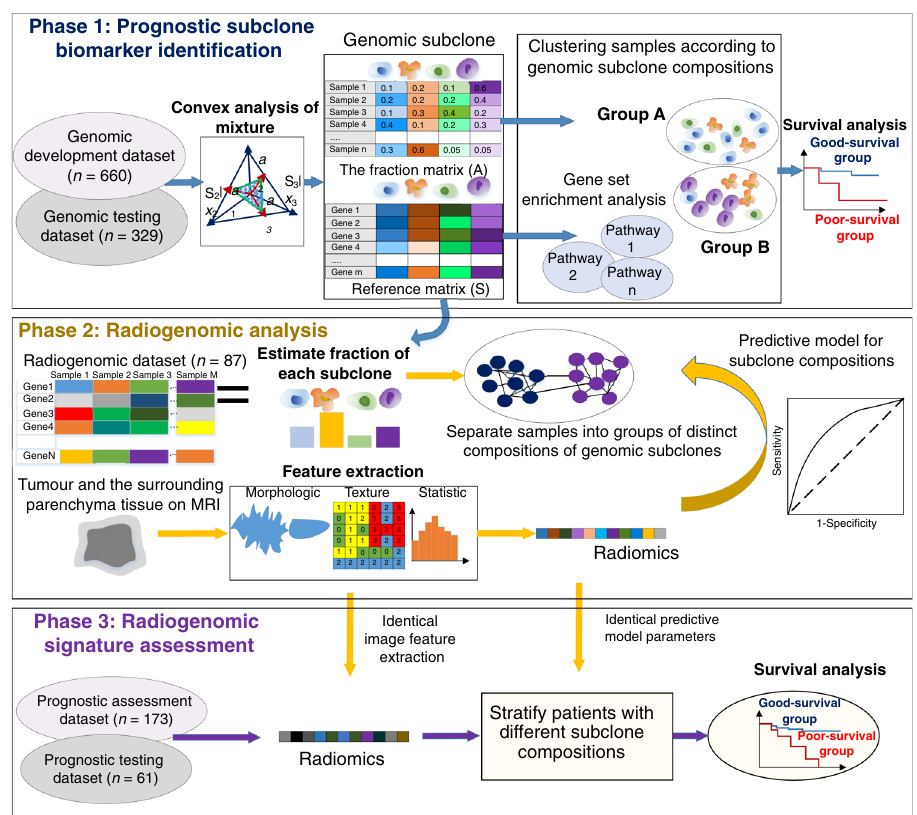
Fig. 1 Framework of the study with three phases. First (phase 1), prognostic subclone biomarkers are identi fi ed using a fully unsupervised deconvolution analysis of gene expression pro fi les. Biological functions of the subclones are inferred by gene set enrichment analysis. Second (phase 2), radiogenomic signatures are established by mapping radiomic features onto compositions of prognostic subclones. Third (phase 3), radiogenomic signatures are assessed on another two independent datasets containing imaging and survival outcomes data.